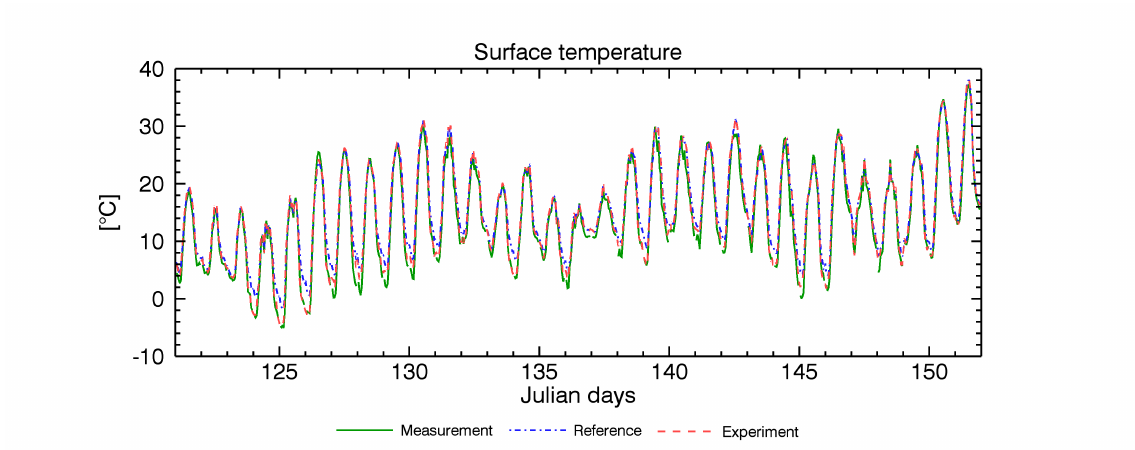
Figure 8. Diurnal cycles of the surface temperature as measured at Falkenberg on 1–31 May 2011 (Julian day 121–151) compared to the results of the reference version of TERRA and of the new scheme based on the skin temperature formulation by Viterbo and Beljaars [18]